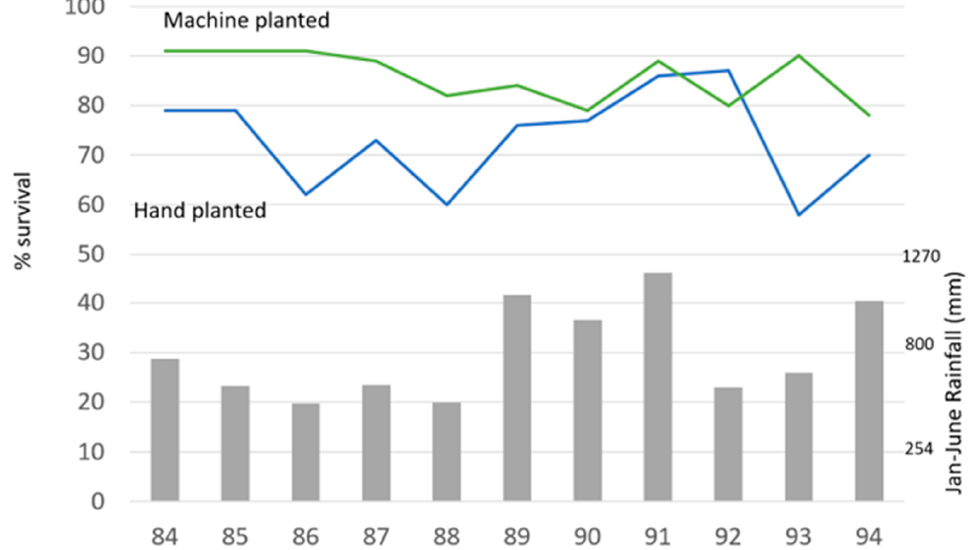
Figure 10. Survival of bareroot loblolly pine in northeast Alabama varied with rainfall and planting method. Over the 11-year period, early survival averaged 86% and 75% for machine and hand planting, respectively. The least significant difference ( α = 0.05: one-tail test is − 6.4%). Data from [69].